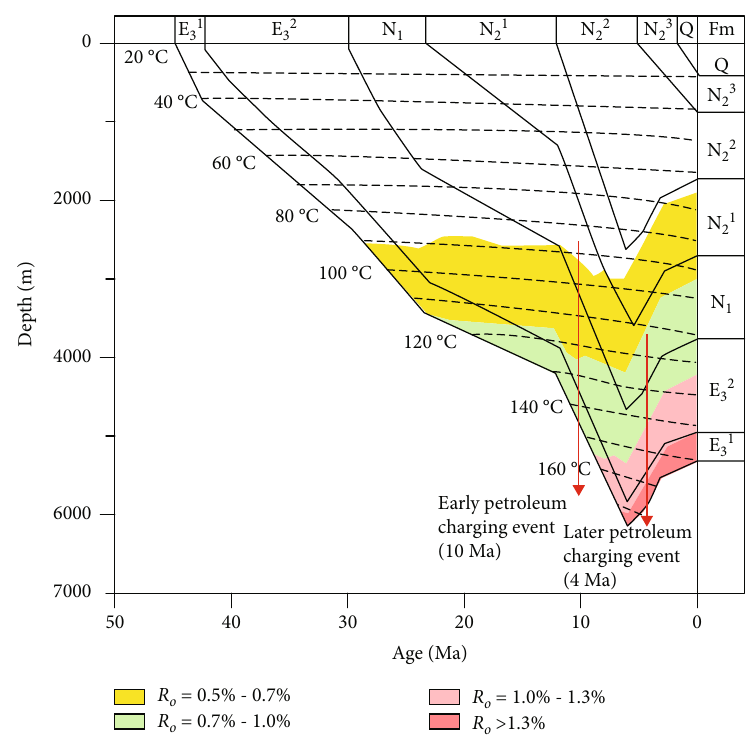
Figure 9: Sedimentary burial pro fi le for the Yingdong fi eld in the western Qaidam Basin (modi fi ed after [47]), and burial history is similar with most fi elds in the western Qaidam